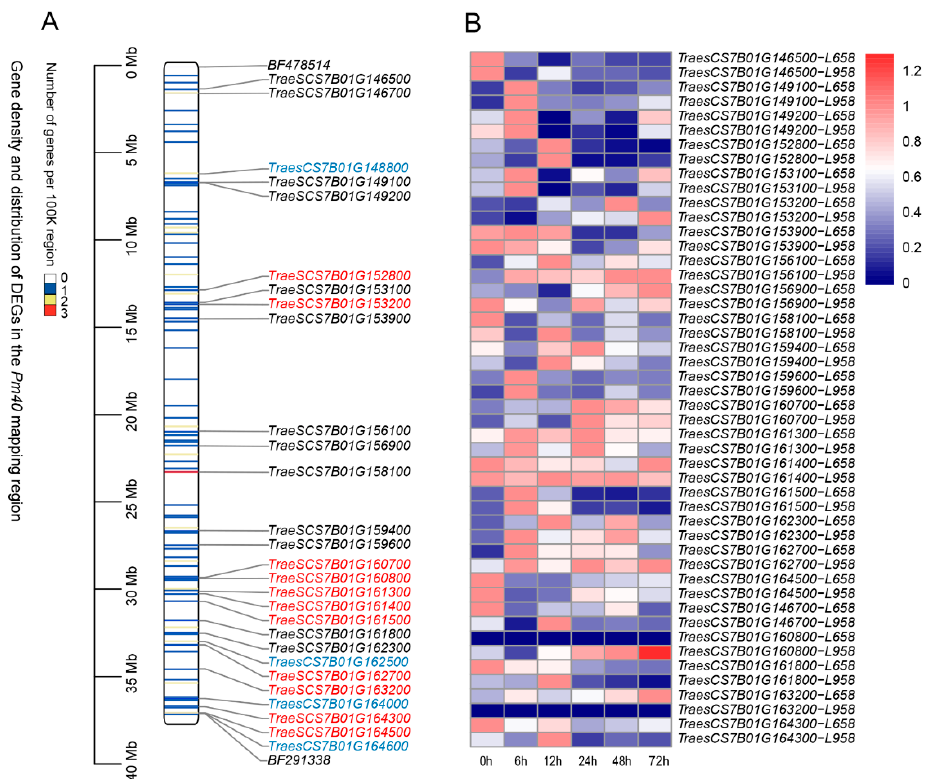
Figure 3. Distribution of differentially expressed genes and expression trends after inoculation with powdery mildew fungus. ( A ) Distribution of differentially expressed genes in the mapping interval of Pm40 (the genes in red indicate those with mutations that probably affect genes). ( B ) The expression trends of DEGs in the resistant line L658 and susceptible sister line L958 at 0 (without inoculation), 6, 12, 24, 48, and 72 h post-inoculation. Heat map drawn based on log2 RPKM values +1 converted to percentages.